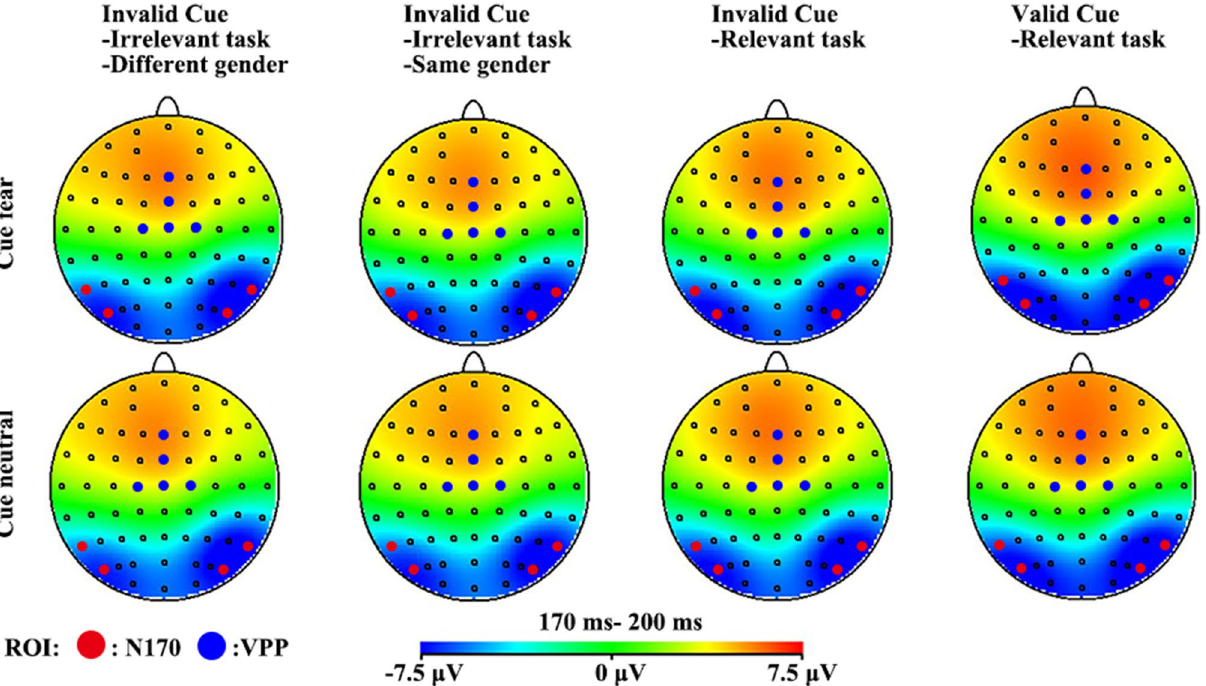
Figure 3. Topographic maps representing the scalp distribution of the N170 and VPP (170–200 ms) for the fearful and neutral faces in four top-down controls, respectively. The figure was plotted by the Brain Vision Analyzer 2 and Photoshop CS6